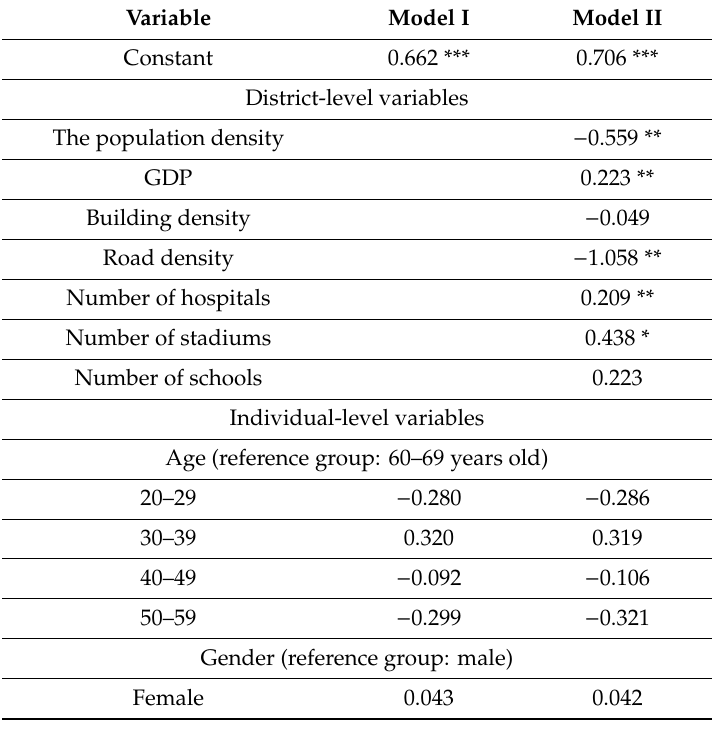
Table 3. Results of the FPHEB’s PUPS in “district–individual”